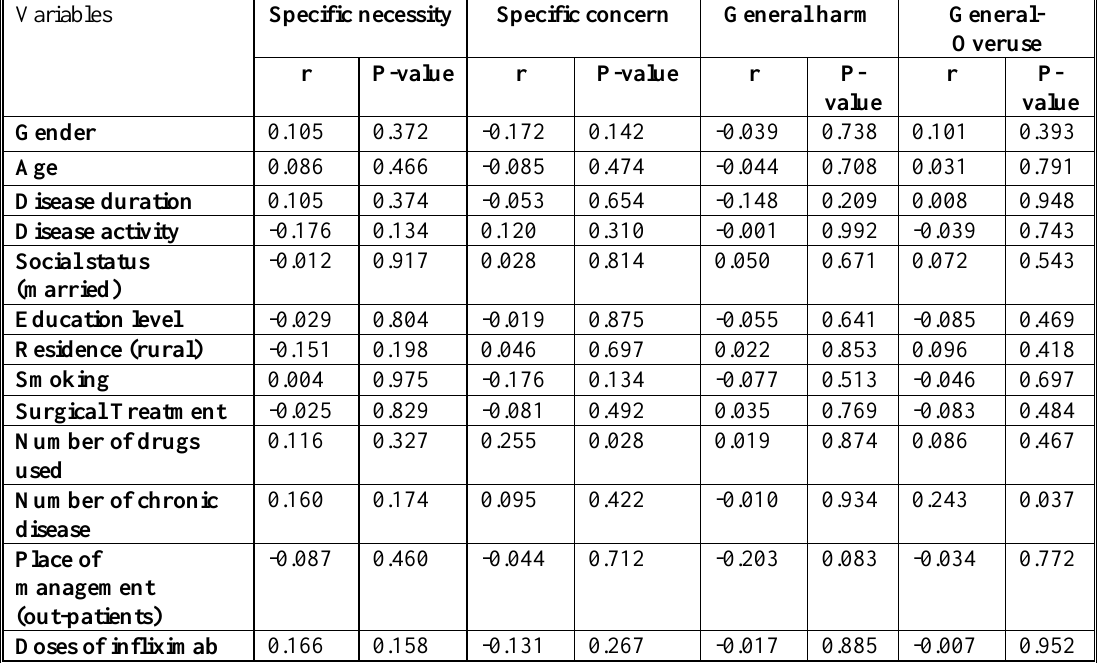
Table 7. Linear regression analysis between BMQ components and other variables for UC patients Variables